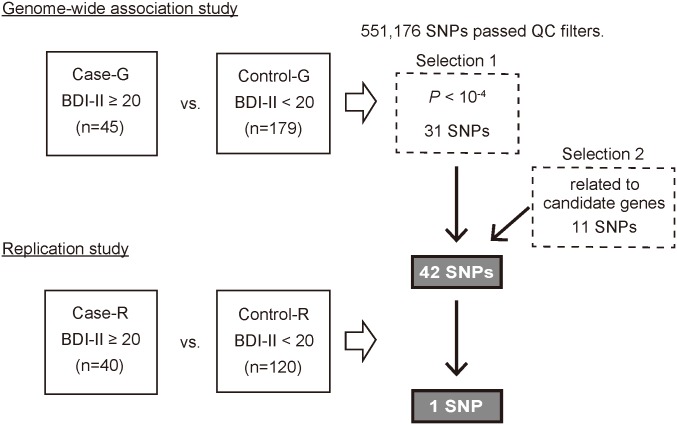
Outline of the study design.BDI-II, Beck Depression Inventory-II; SNP, single nucleotide polymorphism; QC, quality control; OR, odds ratio.